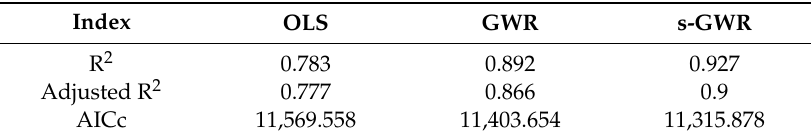
Table 4. Comparison of the models’ fitting